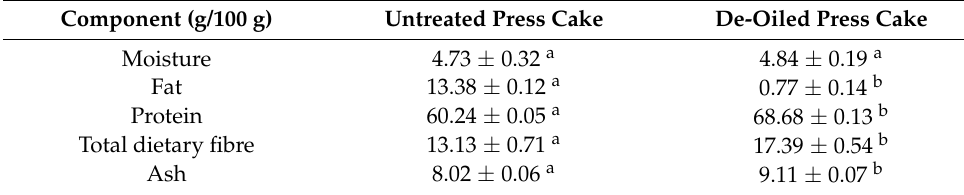
Table 1. Composition of untreated and de-oiled pumpkin seed press cake. Component (g/100